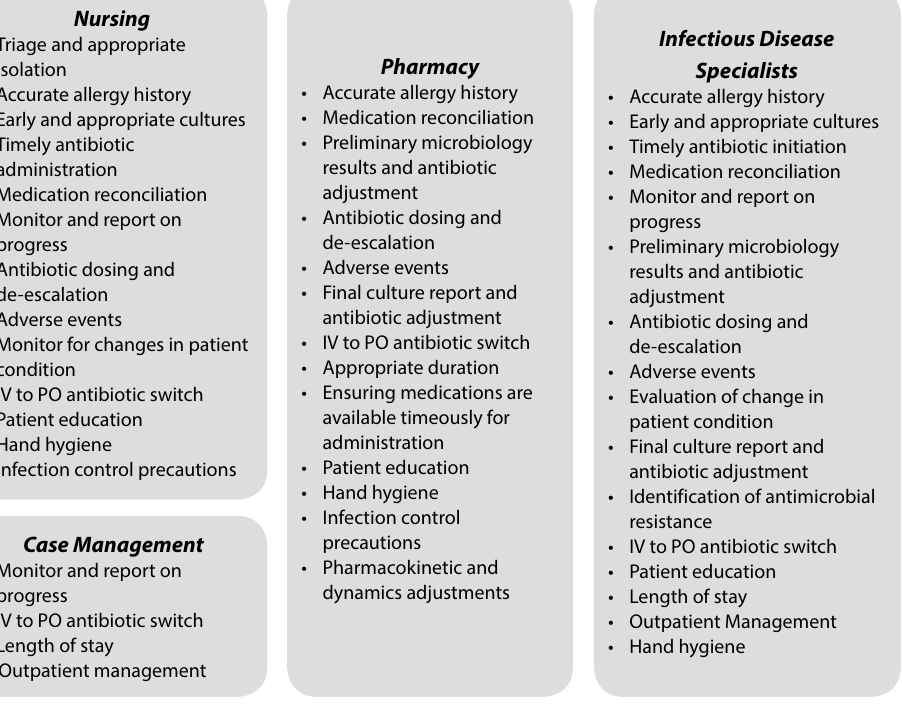
Figure 1. The attributes of function within current antimicrobial stewardship models